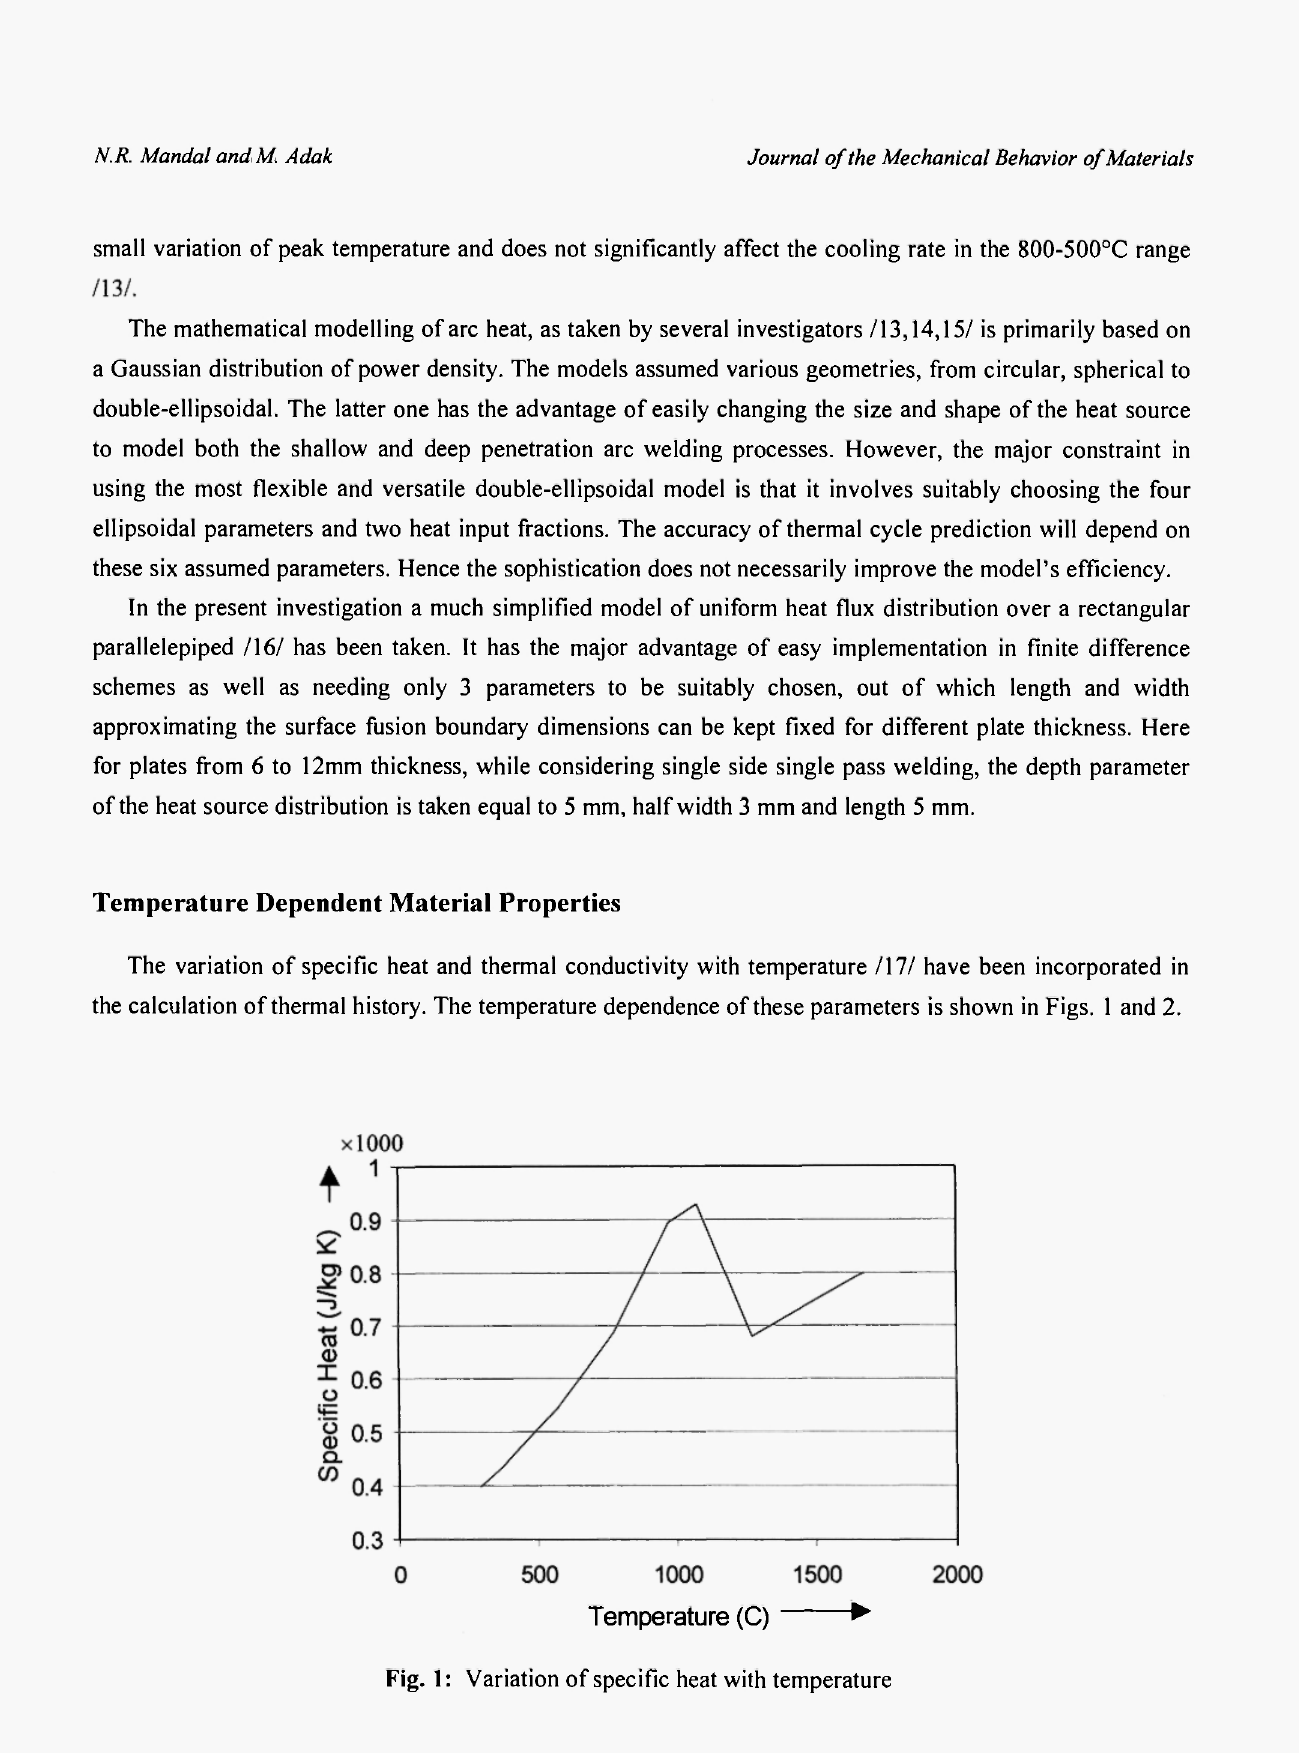
Fig. 1: Variation of specific heat with